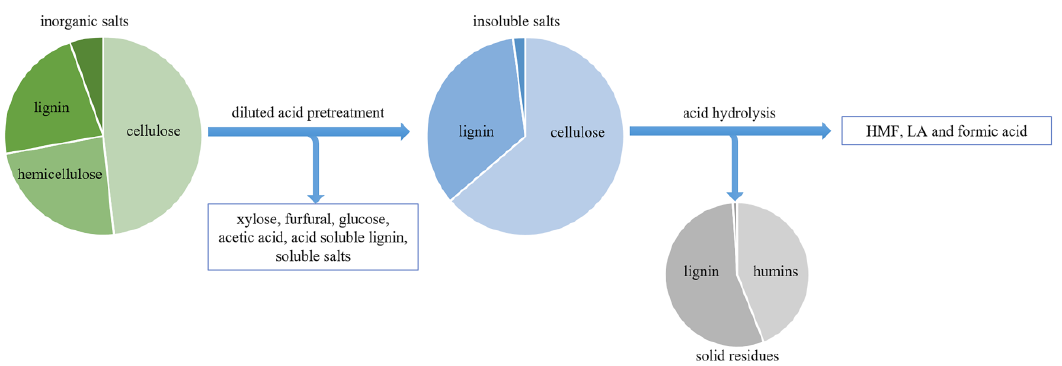
Figure 3. Acid pretreatment and the hydrolysis of lignocellulosic biomass. Reproduced from Ref. [66] with permission; copyright 2018, “Renewable and Sustainable Energy Reviews”,